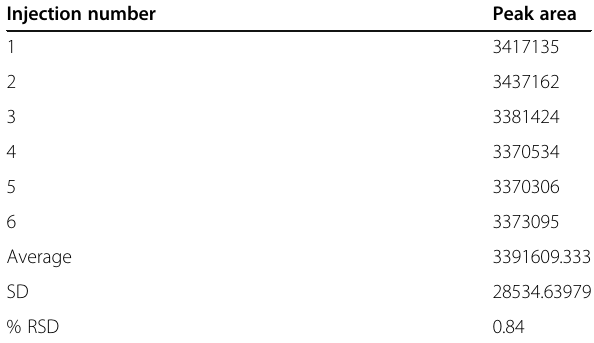
Table 3 Result of system precision Injection number